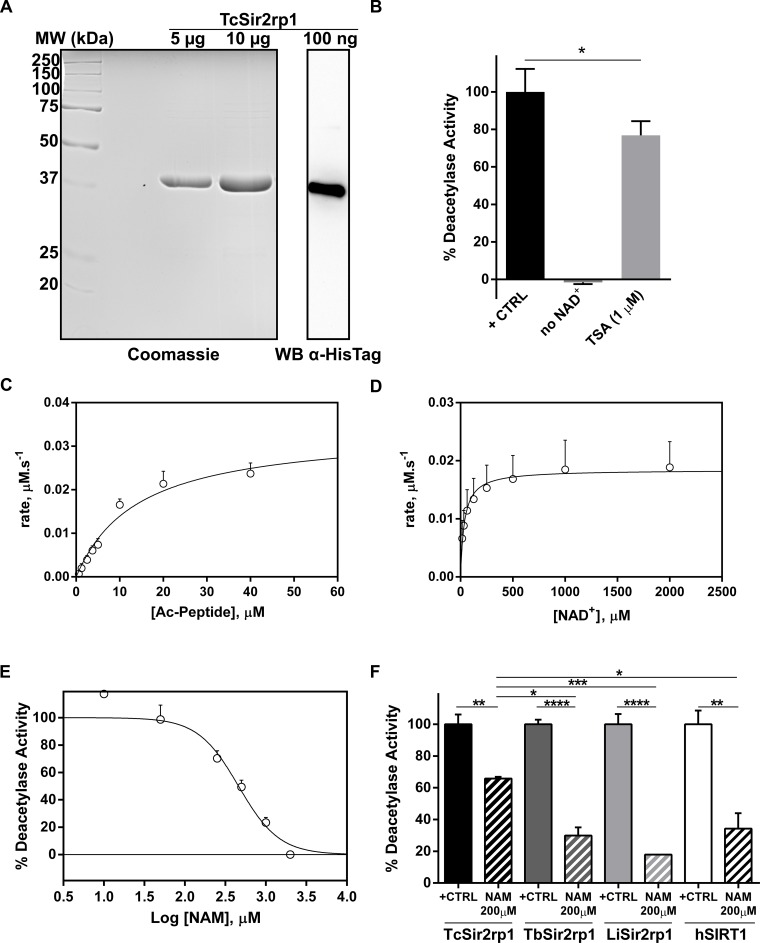
Trypanosoma cruzi Sir2rp1 characterization and inhibition by nicotinamide.A) Purity analysis of 5 and 10 μg of TcSir2rp1 by SDS-PAGE stained with Coomassie brilliant blue (left panel). Western Blot analysis of 100 ng of the hexa-histidine tailed TcSir2rp1 recombinant protein with an anti-HisTag antibody. B) TcSir2rp1 deacetylase activity was measured with a fluorimetric kit in the presence or absence of NAD+ (+CTRL), and in presence of 1 μM of trichostatin A (TSA). Bars represent mean + standard deviation. Data from 3 independent experiments. C) Deacetylation reactions for the determination of the kinetic constants of Ac-peptide. NAD+ was fixed at 2000 μM while Ac-peptide was varied (0.63 to 40 μM). Plots of initial velocities versus [Ac-peptide] were fitted to the Michaelis-Menten equation, yielding the kinetic constants (see Table 1). D) Deacetylation reactions for the determination of the kinetic constants of NAD+. Ac-peptide was fixed at 40 μM while NAD+ was varied (15.63 to 2000 μM). Plots of initial velocities versus [NAD+] were fitted to the Michaelis-Menten equation, yielding the kinetic constants (see Table 1). Dots and error bars represent mean + standard deviation. C-D) Data from 3 independent experiments. E) Dose-response curve of TcSir2rp1 inhibition by nicotinamide. Data represents the average + standard deviation of three independent experiments. F) Differential inhibition of TcSir2rp1, TbSir2rp1, LiSir2rp1 and hSIRT1 by a dose of 200 μM of nicotinamide (NAM). Bars represent mean + standard deviation. Data from 2 independent experiments. Differences between the experimental groups were considered significant as follows: * p<0.05, ** p<0.005, *** p<0.001 and **** p<0.0001.